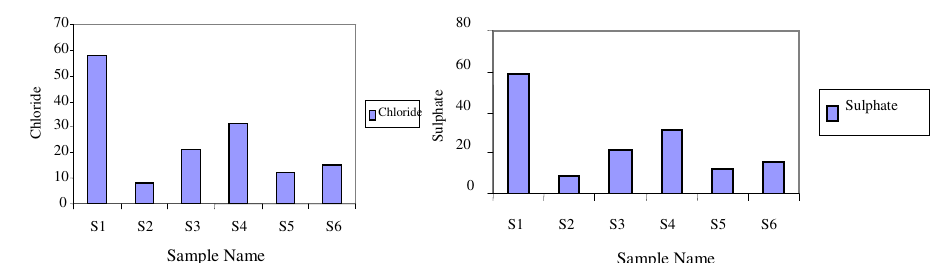
Figure 7. Chloride in various sample Figure 8. Sulphate in various sample